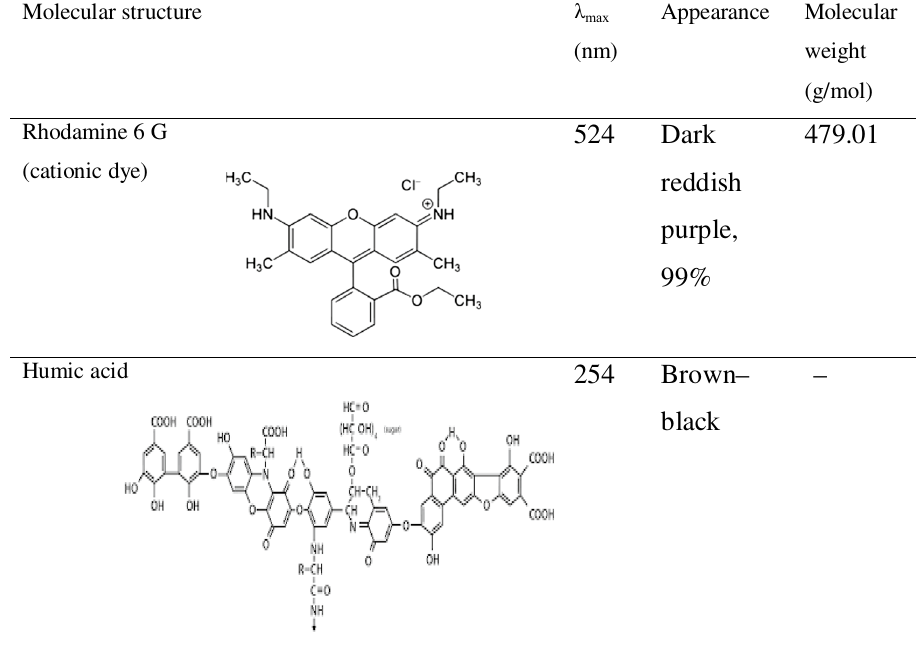
Table 1 Characteristics of Rh6G and HA